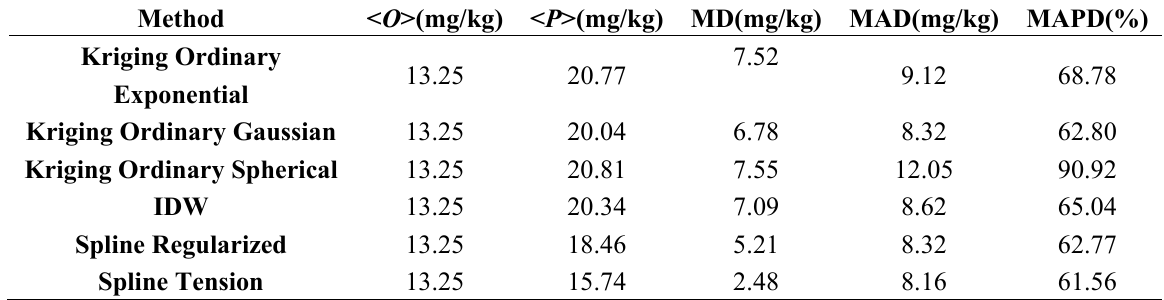
Table 3. Statistics of model performance for predicting soil available phosphorus.